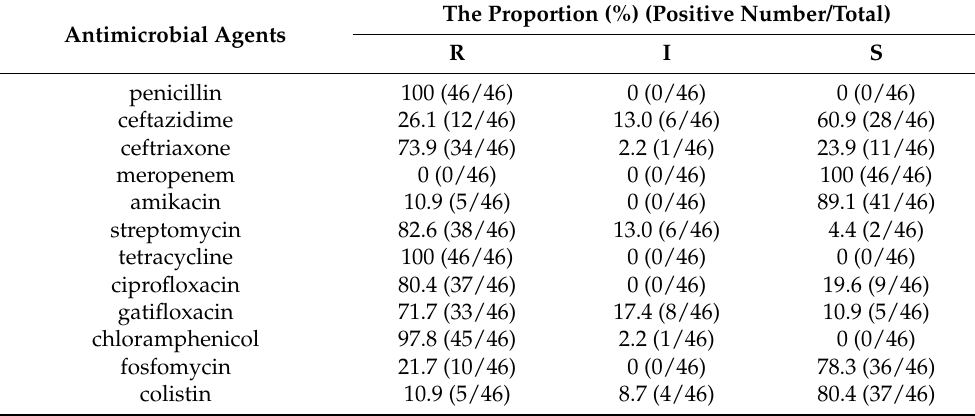
Table 4. Antimicrobial resistance of sul3 positive E. coli . Antimicrobial